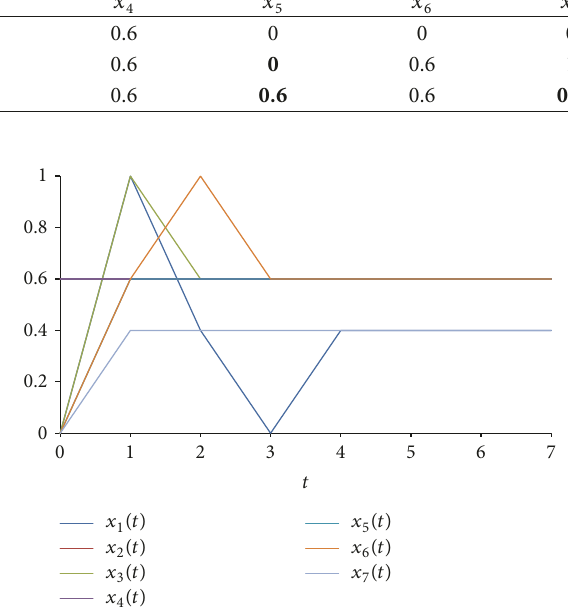
Figure 3: Dynamics of the IBN model for WNT5A gene regulation with initial state conditions 𝑋(0) = [0;0.6; 0; 0.6; 0; 0; 0] and minimum operator used as 𝑡 -norm. The IBN model reaches the point attractor in 4th iteration 𝑋(4) = [0.4; 0.6; 0; 0.6; 0; 0.6; 1] .